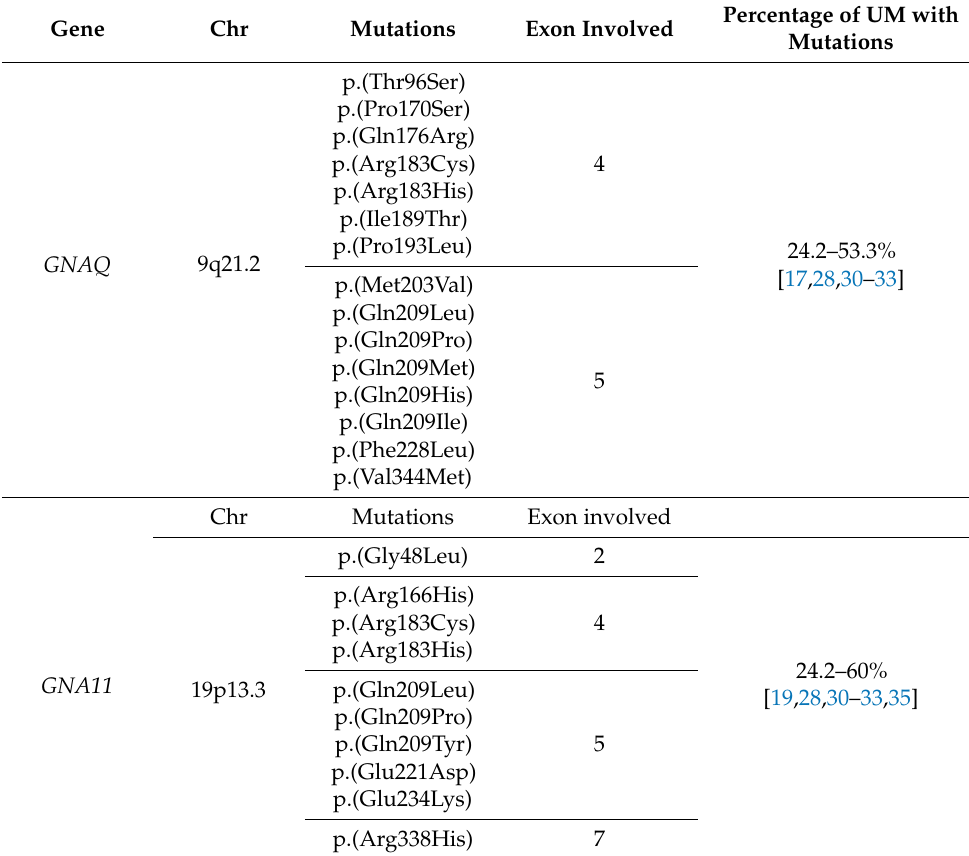
Table 1. Summary table of the different mutations described for GNAQ and GNA11 genes in uveal melanoma. Chr: chromosomes. Gene Chr Mutations Exon Involved